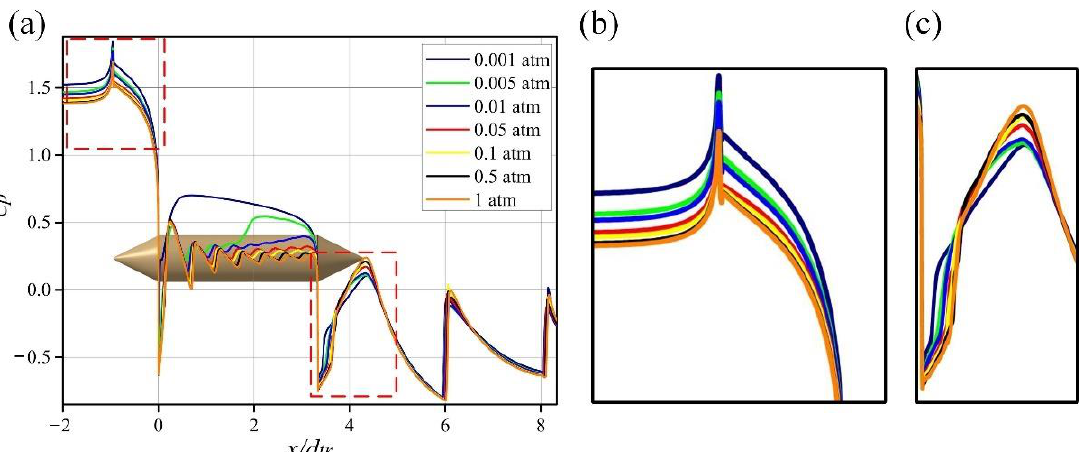
Figure 16. ( a ) The distribution of C P along the axis of the tube and the longitudinal line on the train surface at different ambient pressures in the tube, ( b ) enlarged view of the C P distribution in front of the train head, ( c ) enlarged view of the C P distribution in the near weak.